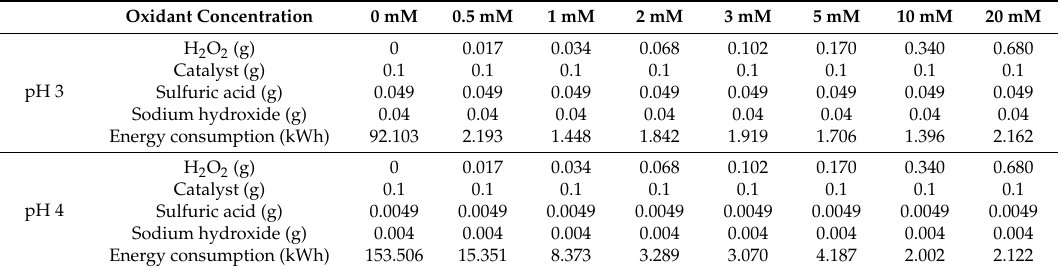
Table 12. Inventory of the input for the treatment of 1 L of Milli-Q water contaminated with BPA (20 / HA (100 mg / L) at pH 3 and 4. µ M) in the presence of di ff erent H 2 O 2 concentrations catalyzed by Fe 3 O 4 Oxidant